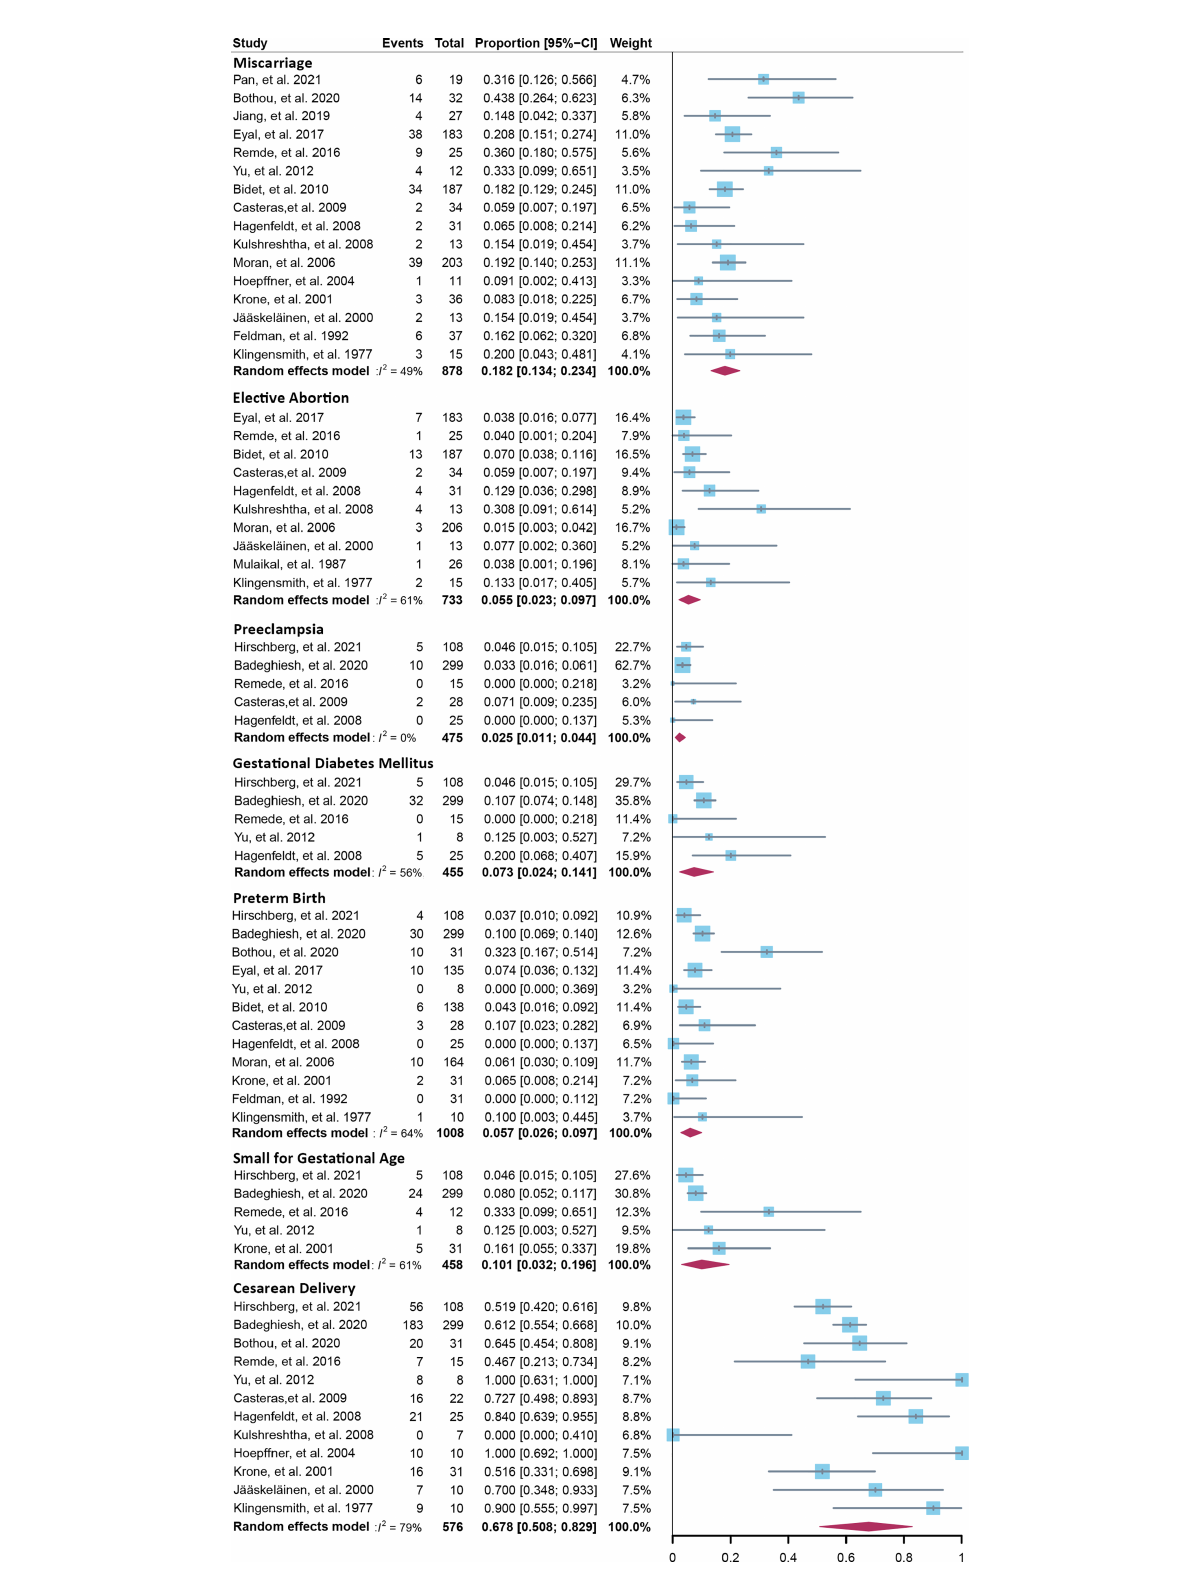
FIGURE 3 Prevalence of pregnancy complications in CAH patients. CAH, congenital adrenal